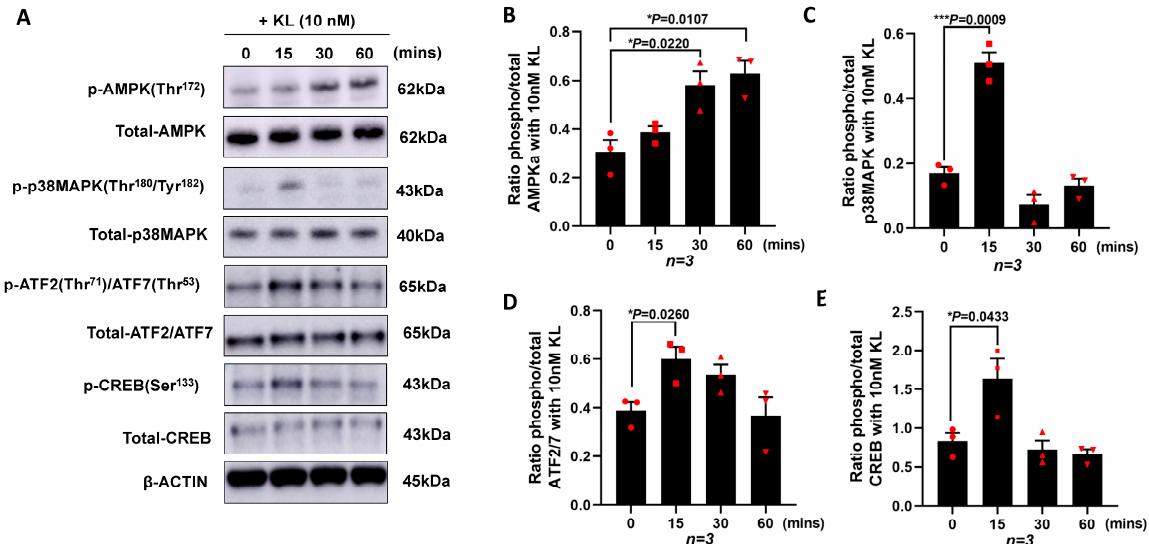
Figure 2. KL protein promotes the transcription of PGC-1 α in RPE by increasing the phosphorylation of AMPK, p38MAPK, ATF2/7, and CREB. ARPE19 cells were cultured and starved for 24 h prior to being treated with 10 nM of recombinant KL protein for 0, 15, 30, and 60 min. ( A ) Western blots showing the phosphorylation of AMPK at Thr172, p38MAPK at Thr180/Tyr182, ATF2/ATF7 at Thr71/Thr53 and CREB at Ser133 at different time points. Total protein levels are shown for normalization. β -actin was used for internal control. ( B – E ) Relative expression of phosphorylated protein and total protein for each specific target compared with control (0 min, without KL), as determined by densitometry analysis of three independent Western blots. The relative densities of the bands were analyzed using ImageJ software. Unpaired t -test was performed using GraphPad Prism 8.3.0. Graph represents mean ± SEM, n = 3, * p ≤ 0.05, *** p ≤ 0.001.